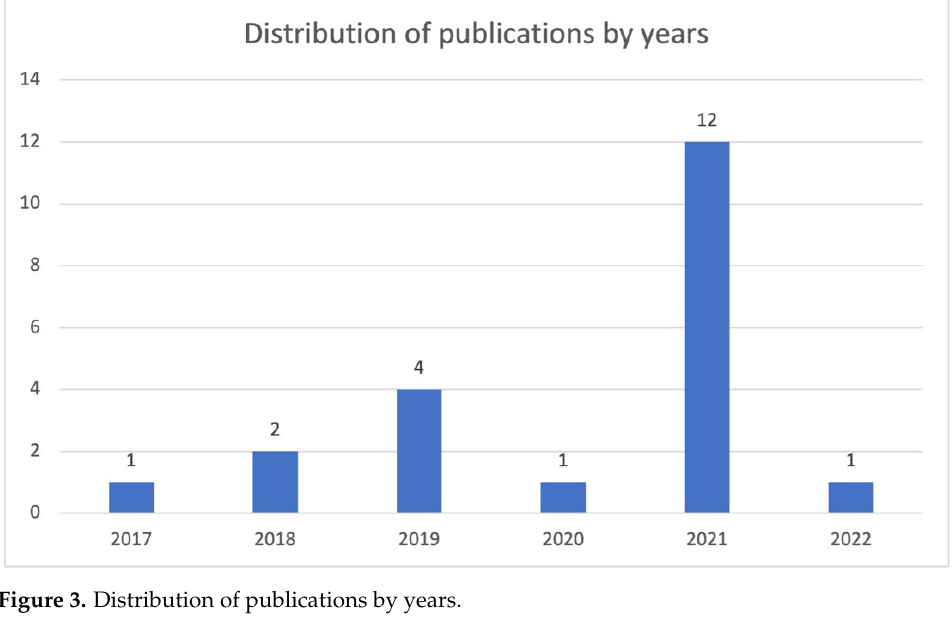
Figure 3. Distribution of publications by years.